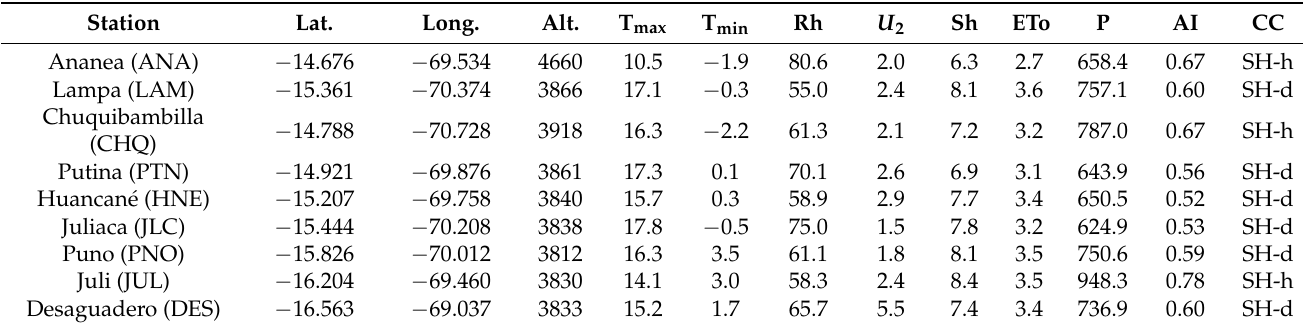
Table 1. Coordinates of the weather stations used, average of the meteorological variables, aridity index and climatic